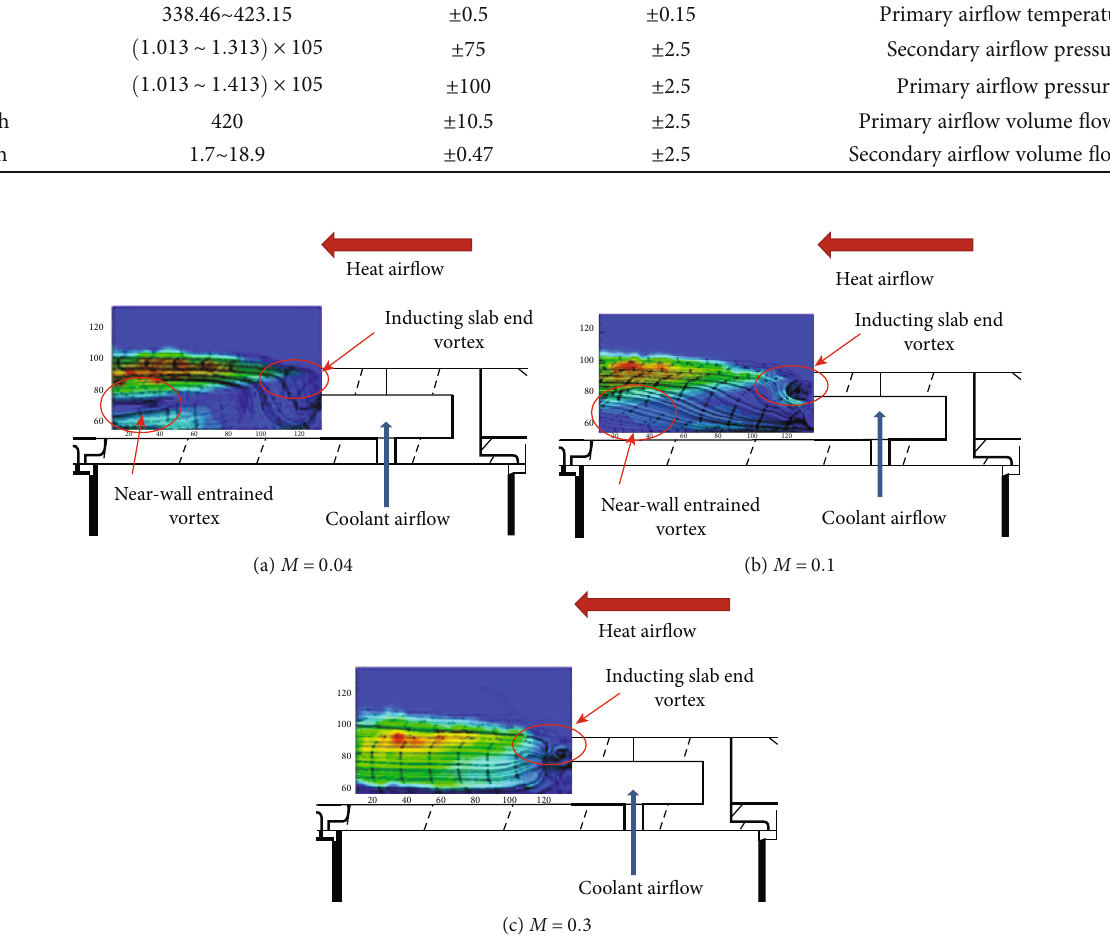
Figure 8: Flow fi eld pattern at di ff erent blowing